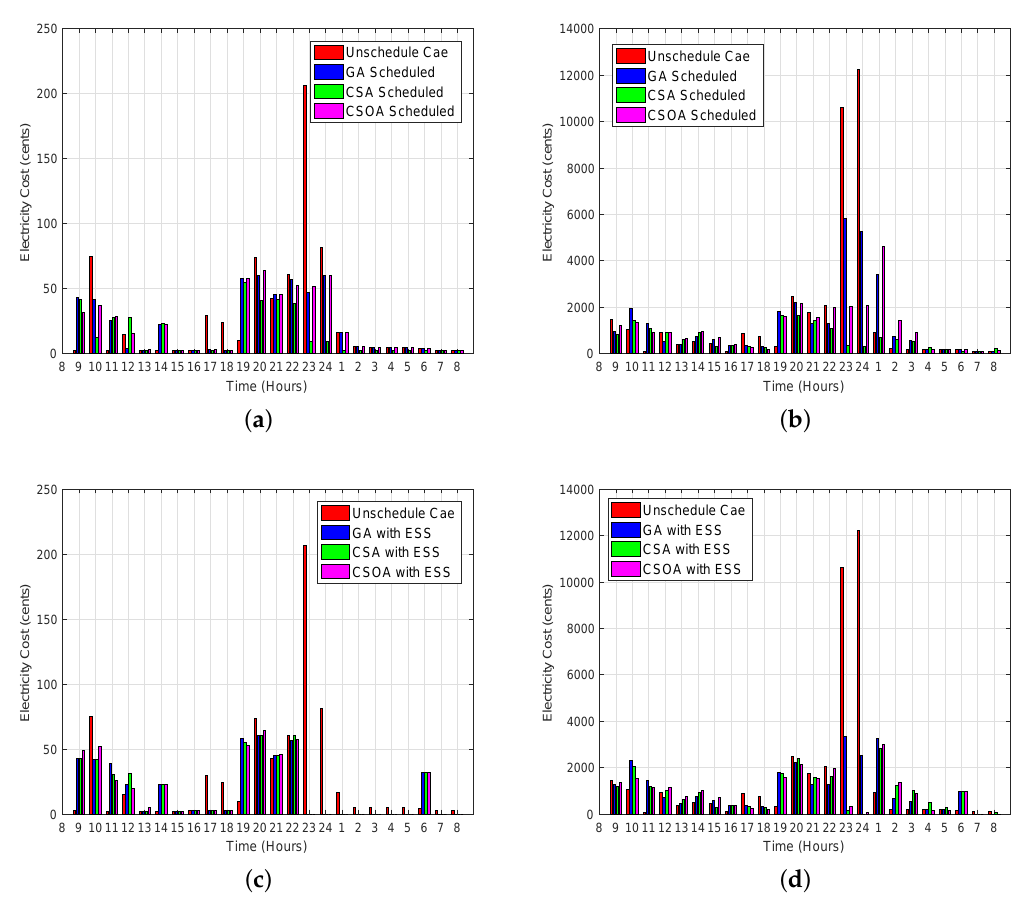
Figure 11. Hourly electricity cost using CPP signals. ( a ) Hourly electricity cost without ESS for a single smart home; ( b ) hourly electricity cost without ESS for 30 smart homes; ( c ) hourly electricity cost with